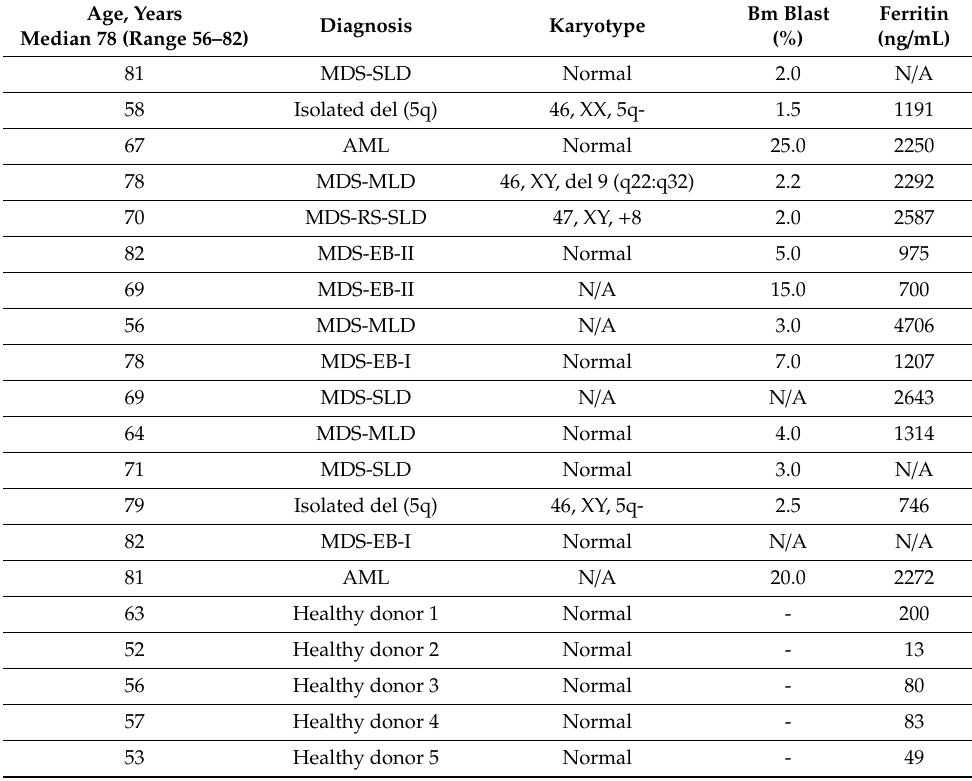
Table 3. Clinical and molecular features of patients and healthy donors enrolled in the